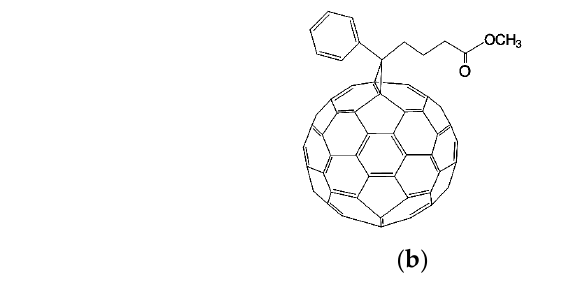
Figure 1. Structures of ( a ) P3HT and ( b ) PC60BM.